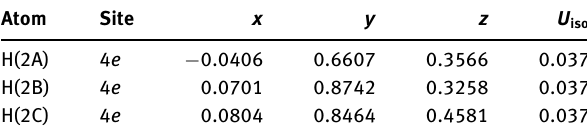
Table 2: Fractional atomic coordinates and isotropic or equivalent isotropic displacement parameters (Å 2